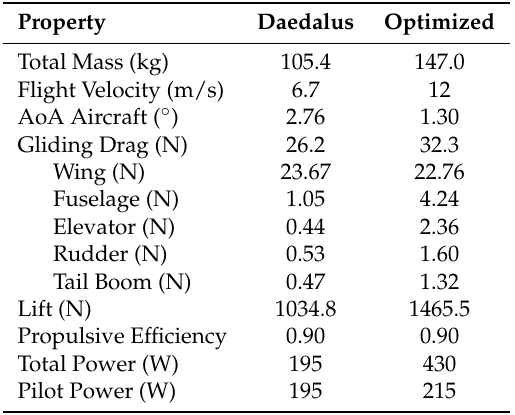
Table 9. Comparison Daedalus versus optimized design in STAR-CCM+.